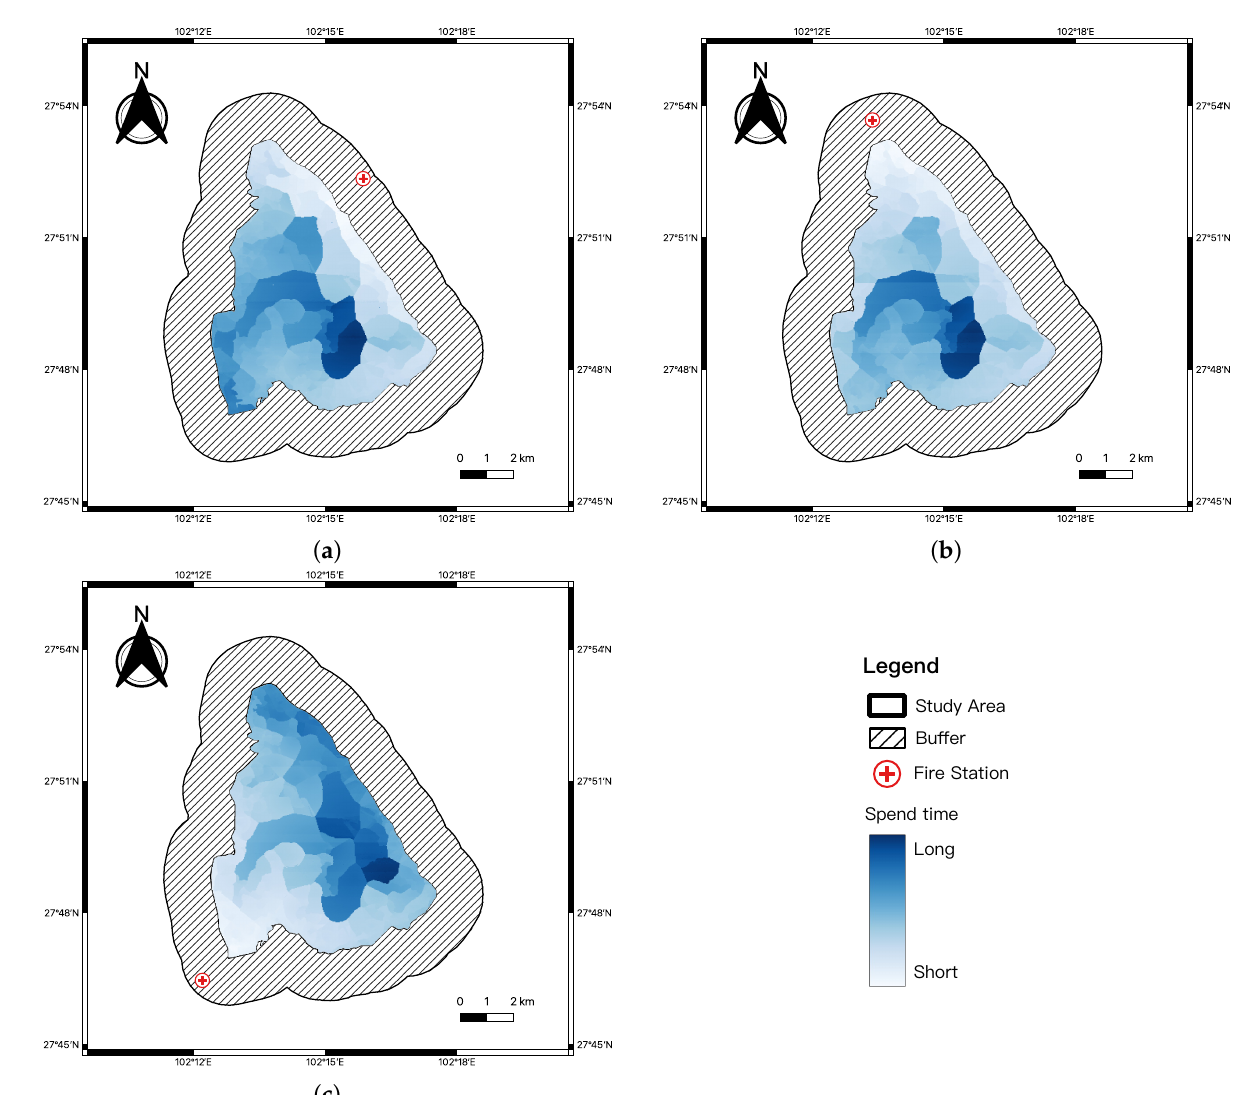
Figure 4. Arrival Time; ( a ) NO.1 fire station; ( b ) NO.2 fire station; ( c ) NO.3 fire station. To simulate the dispatching process of fire resources, the function of road network analysis (Network Analysis) in Quantum GIS was used, taking the fire station as the starting point and the fire point as the end point. This process considers different road grades as shown in Figure 5. The result of this simulation, depicting the time it takes for each of